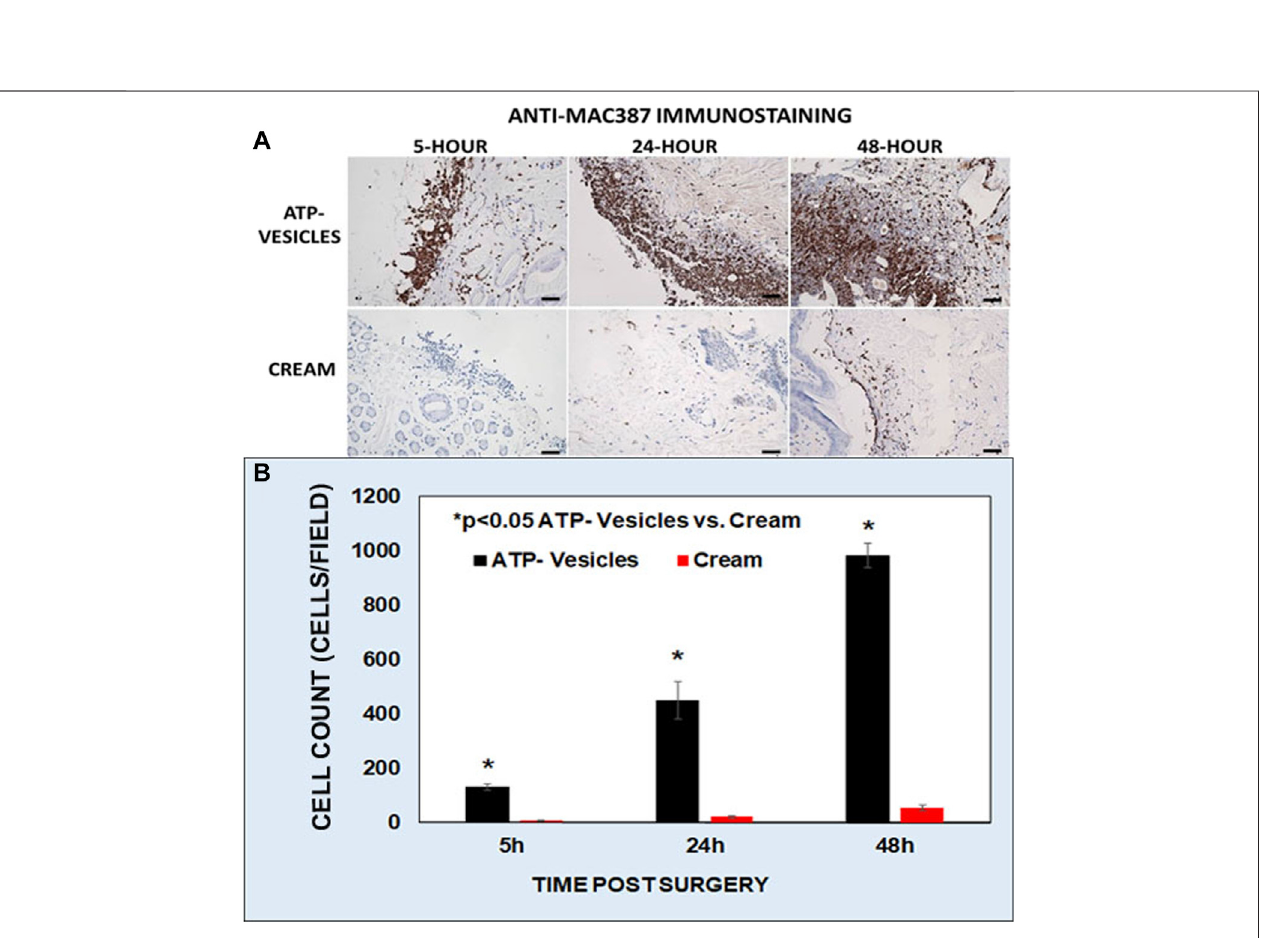
FIGURE5| Arepresentativeimmunohistochemistrycomparisonofmacrophageaccumulationbetweenthetwogroupsat5,24,and48 haftersurgery. (A) .Brown color indicates anti-MAC387 positive immunostaining of macrophages. In this study ATP-vesicle-treated wounds showed signi fi cant macrophage accumulation whereas the control wounds have no such accumulation. Scale bar is 50 μ m. (B) . Graphical representation of the anti-MAC387 positive cells between the two groups.